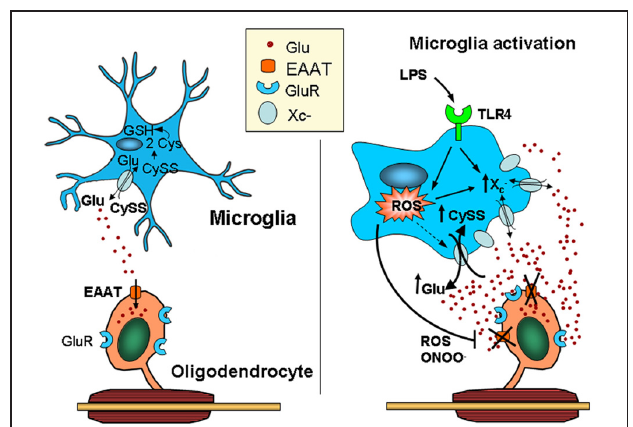
FIGURE 2 | Activated microglia can kill oligodendrocytes via a dual mechanism leading to glutamate excitotoxicity. Microglia release glutamate, primarily through the cystine/glutamate exchange system (system x − c ), which is highly active in these cells due to its high rate of reactive oxygen species (ROS) production. Thus, cystine is intracellularly converted into cysteine, the rate-limiting substrate in glutathione synthesis. Under physiological conditions, glutamate released by the exchanger is efficiently taken up by glutamate transporters expressed in surrounding cells, including astrocytes and oligodendrocytes. In contrast, microglia activated by pro-inflammatory stimuli (e.g., LPS acting at TLR4) release ROS and pro-inflammatory cytokines that impair the function of glutamate transporters, such as TNF- α and IL-1 β , elevating extracellular glutamate levels. In addition, the over-expression of system x − c in activated microglia increases ambient glutamate concentrations. Together, these deleterious effects on glutamate homeostasis can result in excitotoxicity (Domercq et al., 2007). CySS, cystine; Glu, glutamate; LPS, lipopolysaccharide; TLR4, Toll-like